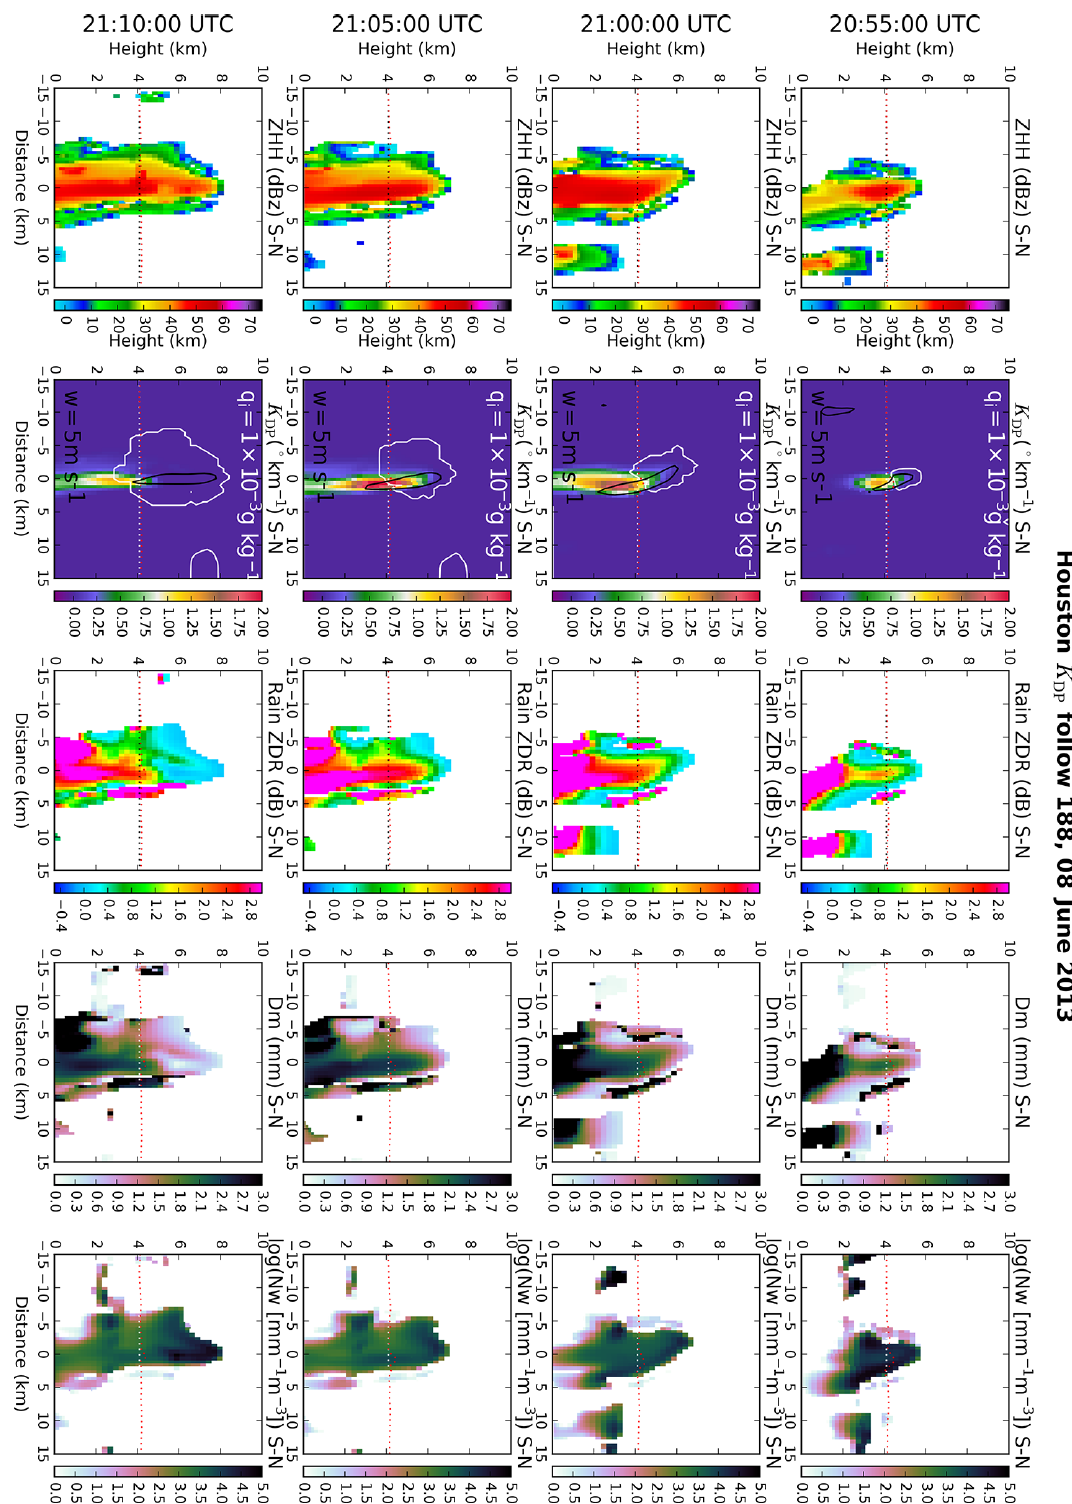
Figure 9. As in Fig. 8 except for simulated K DP column